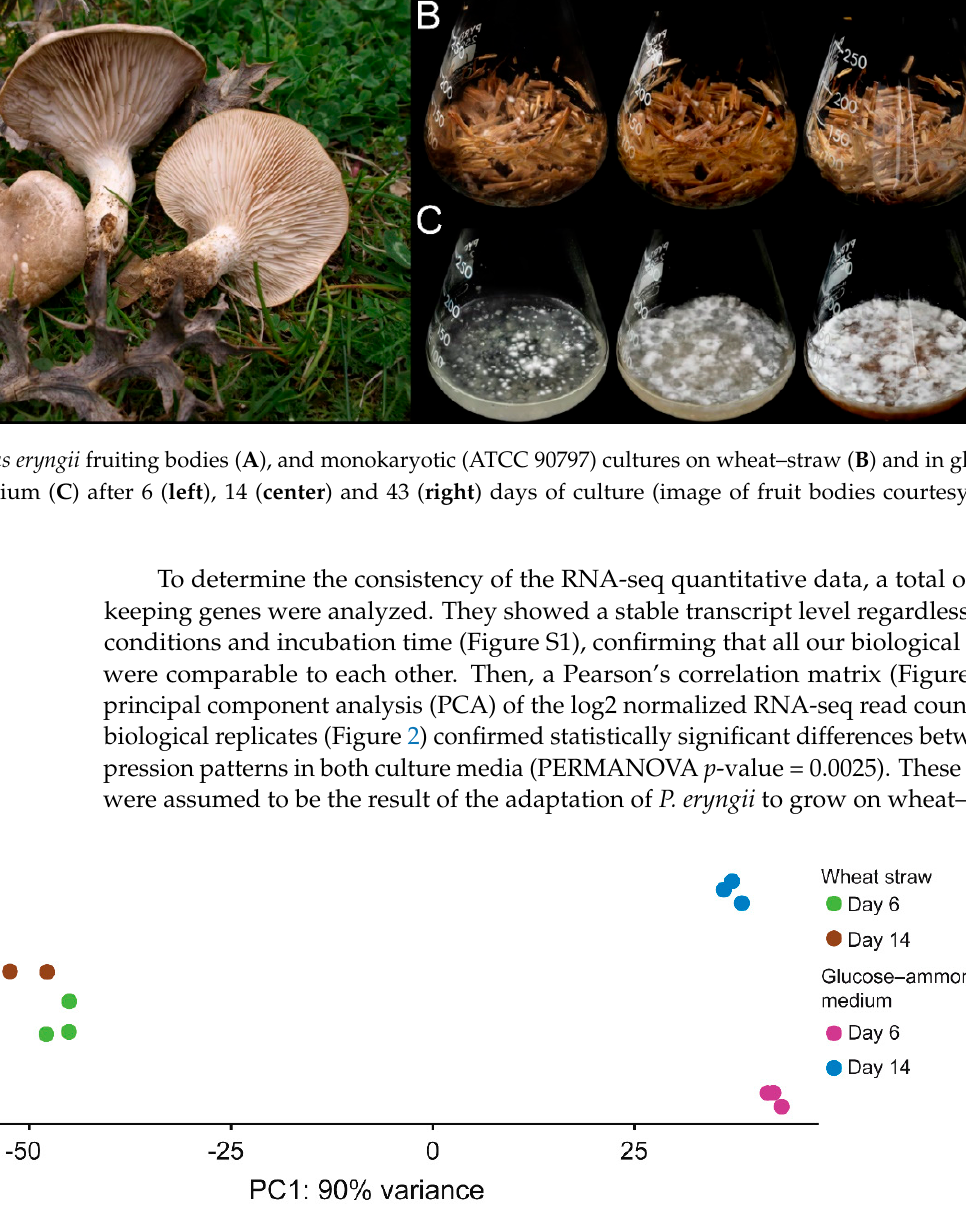
Figure 2 . Principal component analysis of the log2 normalized RNA-seq read counts of 11 biological replicates of P. eryngii growing on wheat – straw and in glucose–ammonium medium for 6 and 14 days. The replicates are shown as colored circles according to the growth conditions: (i) green and brown for cultures of 6 and 14 days on wheat–straw, respectively; and purple and blue for 6 and 14 days of culture in glucose–ammonium medium, respectively.